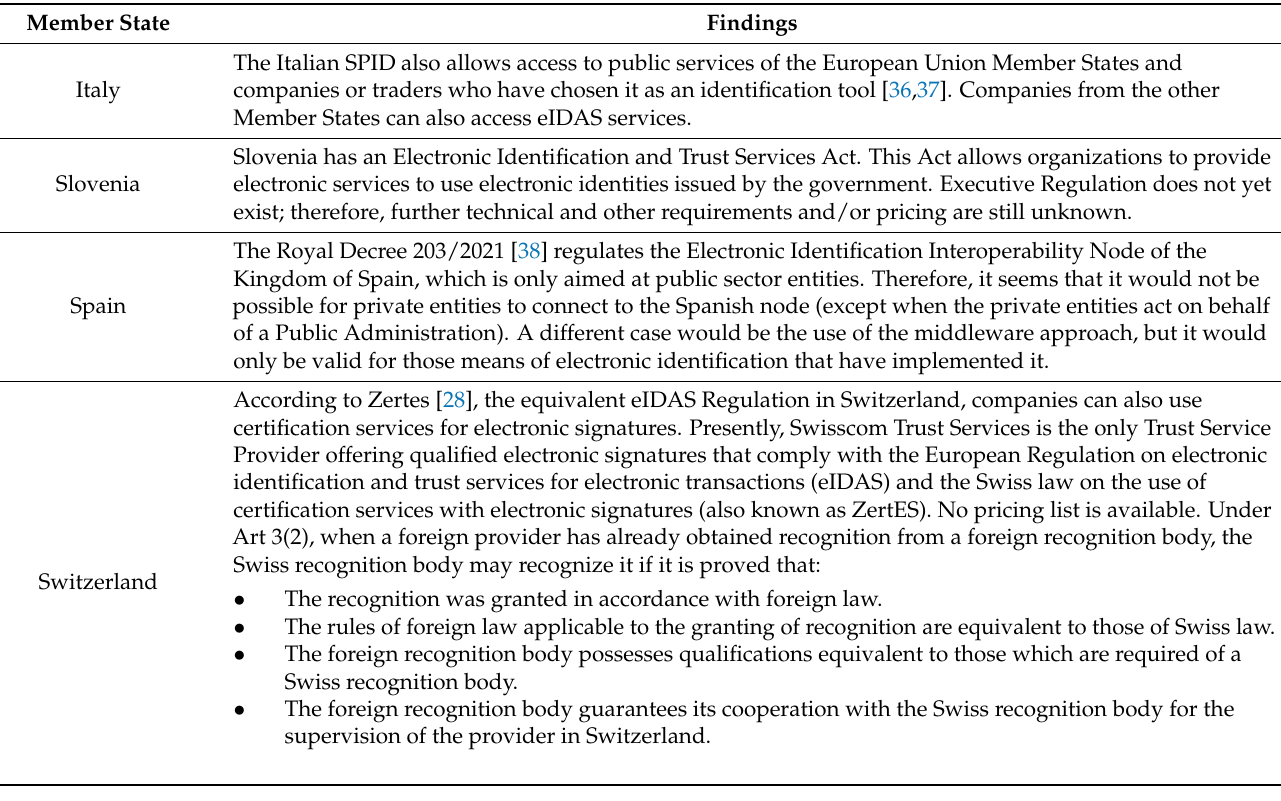
Table 5. Commercial access to the eIDAS network for the sampled